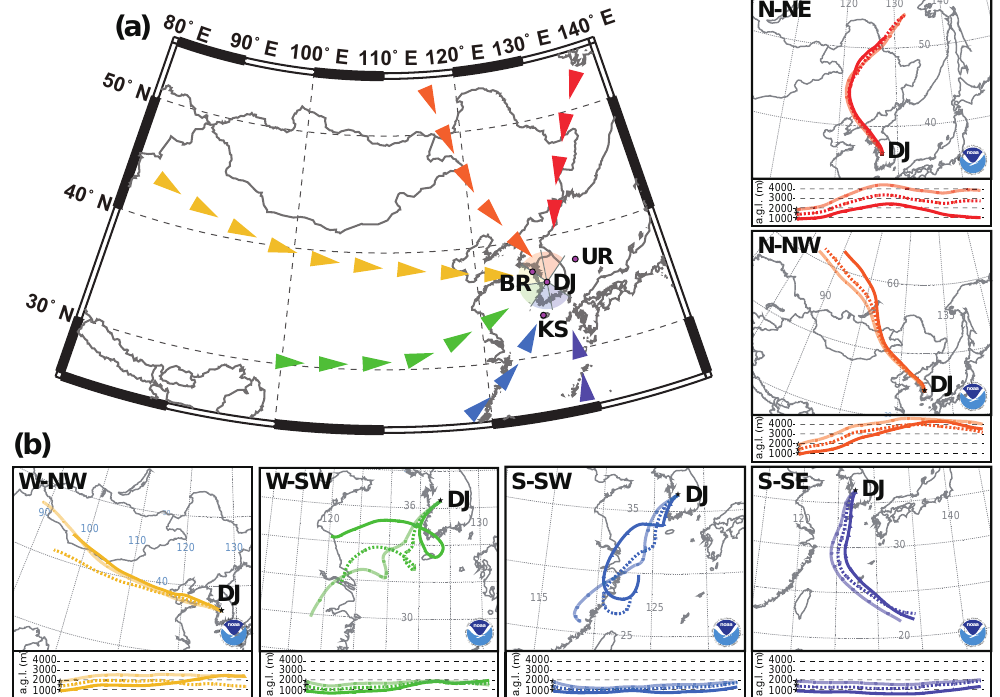
Figure 1. (a) Schematic diagram of dust transport paths. BR: Baekryeongdo, DJ: Daejeon, KS: Kosan, UR: Ulreongdo. (b) Representative examples of HYSPLIT backward trajectories ending at DJ. Trajectories of dust transport at 1000, 1500, and 2000ma.s.l. were traced for 72h. ADSs were classified into six transport paths on the basis of wind azimuth during the first 24h of each ADS event as N–NE (northerly 0 ◦ to northeasterly 45 ◦ ), N–NW (northerly 360 ◦ to northwesterly 315 ◦ ), W–NW (westerly 270 ◦ to northwesterly 315 ◦ ), W–SW (westerly 270 ◦ to southwesterly 235 ◦ ), S–SW (southerly 180 ◦ to southwesterly 235 ◦ ), and S–SE (southerly 180 ◦ to southeasterly 135 ◦ ).